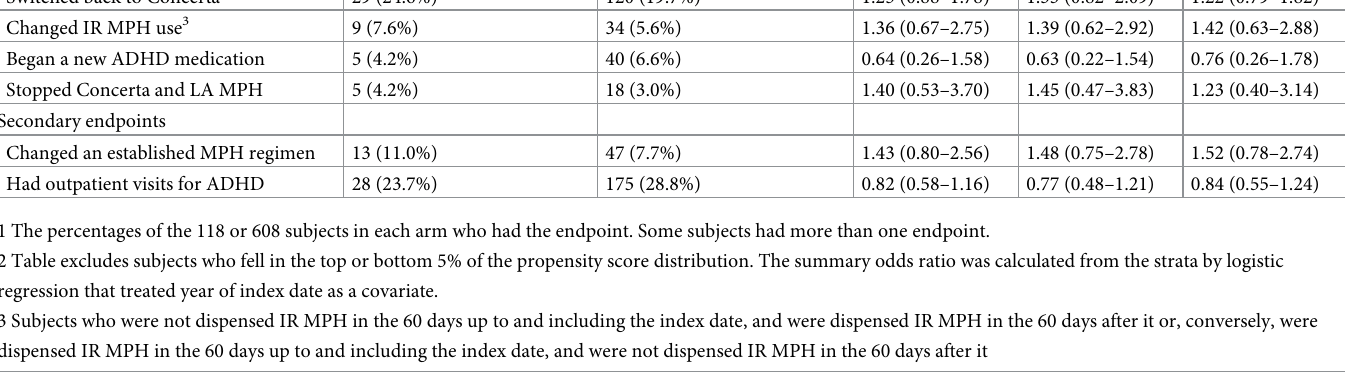
1 Table excludes subjects who fell in the top or bottom 5% of the propensity score distribution. 2 The summary odds ratio was calculated from the strata by logistic regression that treated year of index date as a covariate.